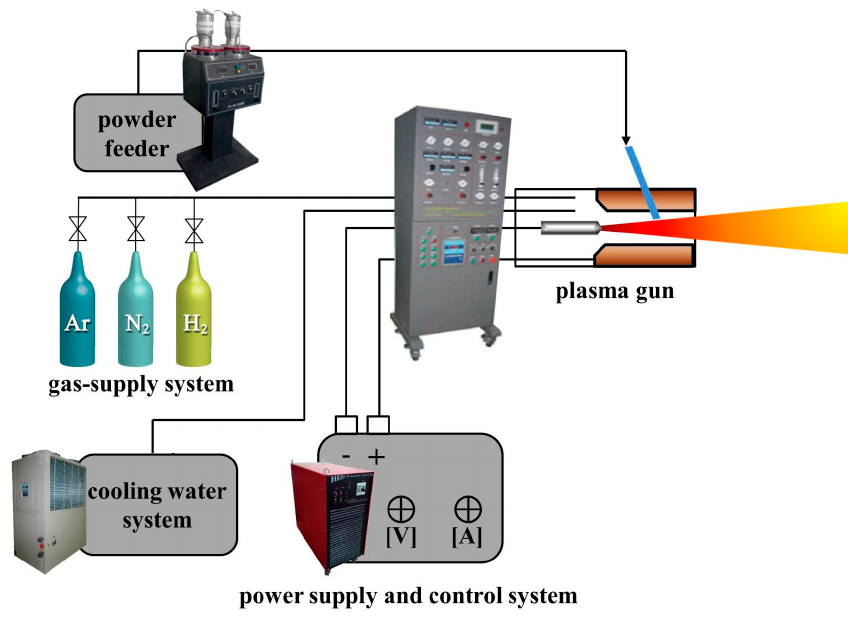
Figure 1. Schematic diagram of the supersonic plasma spraying system.